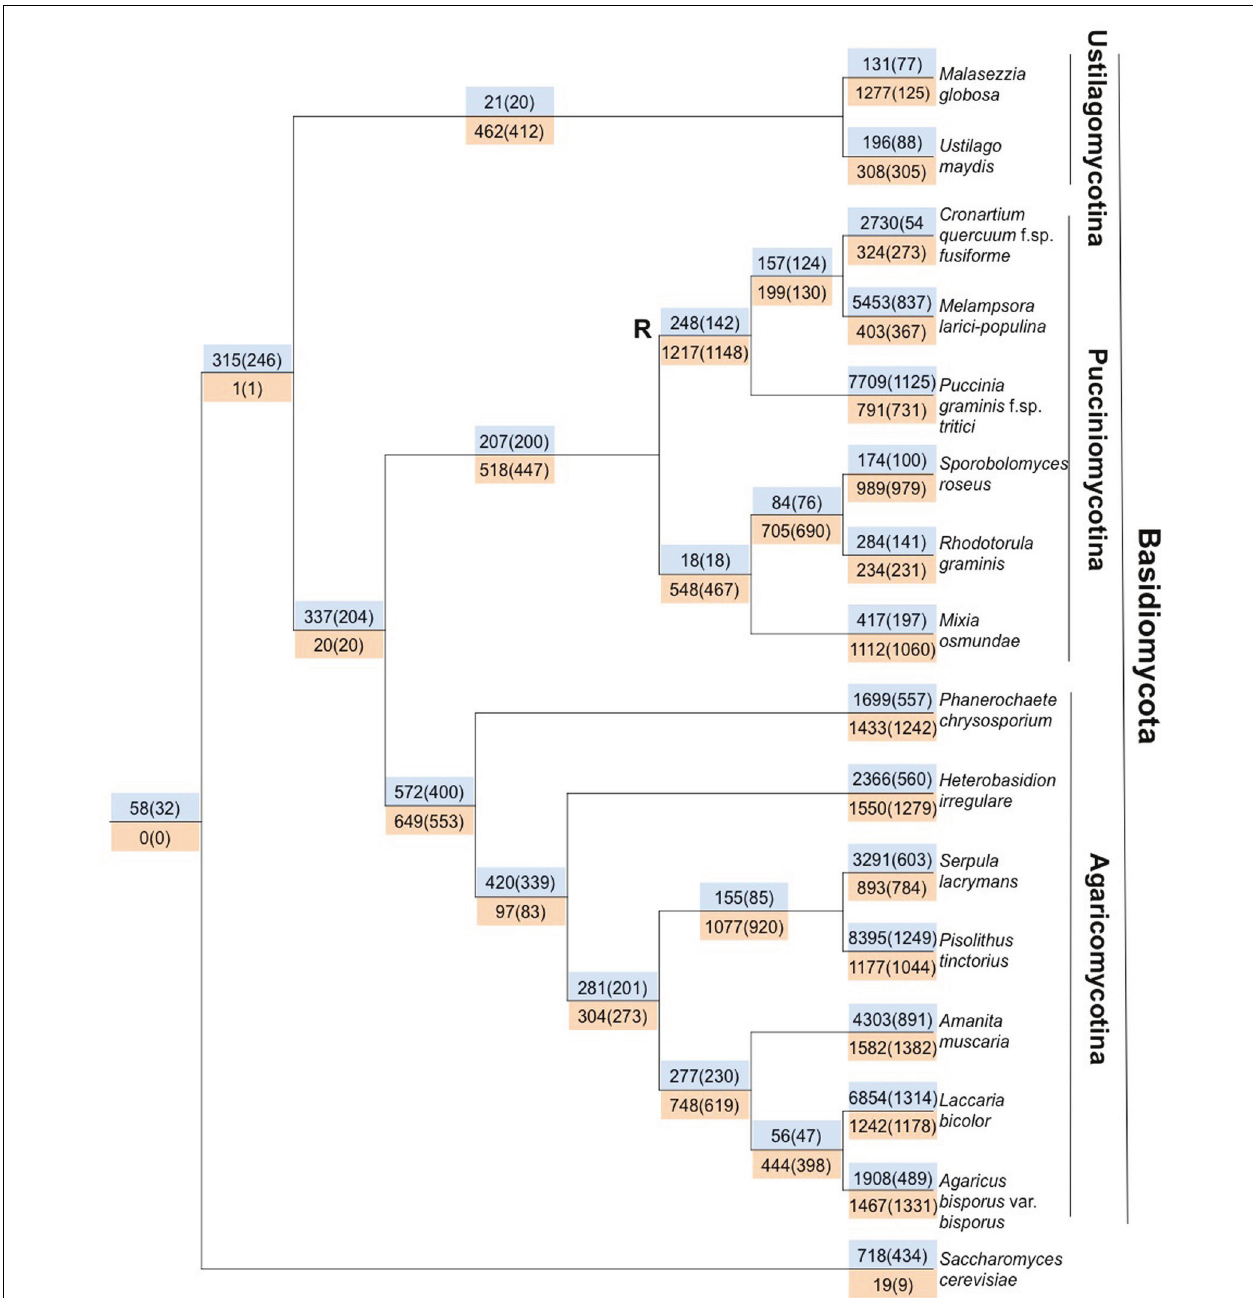
FIGURE 3 | Gene loss and gain in the Basidiomycota fungal lineage highlights shared loss in the rust pathogen lineage and high levels of species-specific gain. Mapping putative gene duplications and losses across 16 fungal taxa. Values in blue are associated with gains/duplications, whereas orange indicates loss.